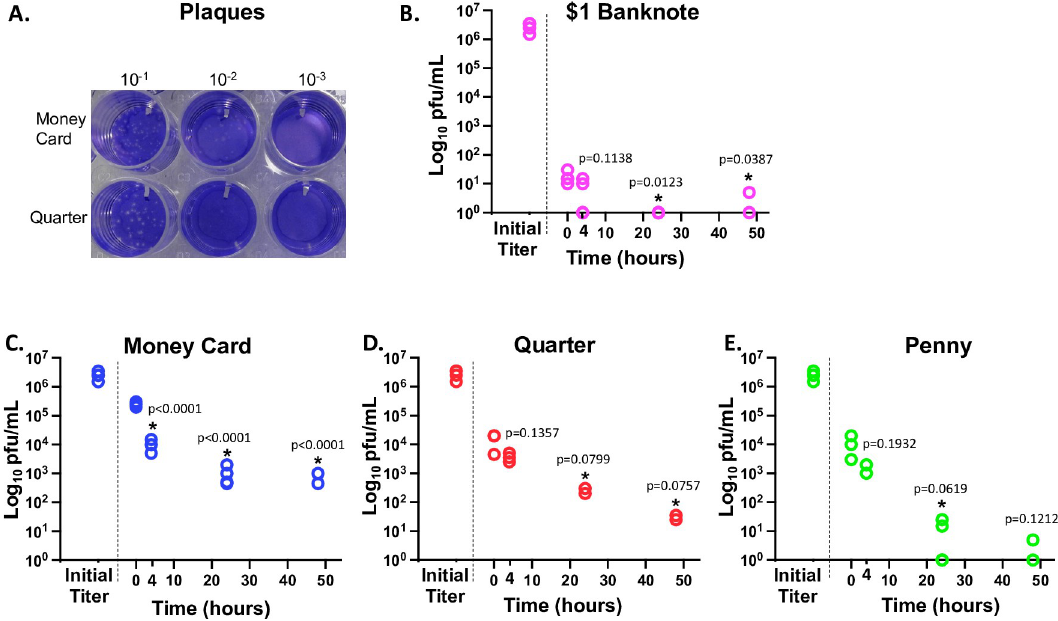
Fig 1. Stability of live SARS-CoV-2 virus on $1 U.S.A. banknotes, money cards, quarters, and pennies. A) Representative plaques of a SARS-CoV-2 on VERO cells from this study at the four-hour time point. B) Recovery of virus after inoculation of $1